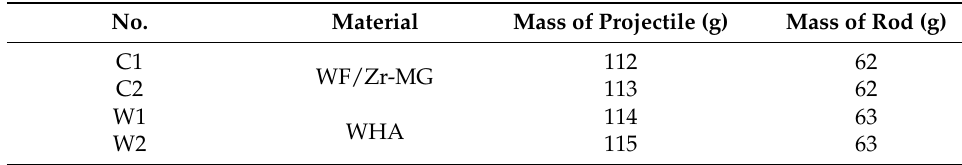
Figure 3. Setup of experiments.